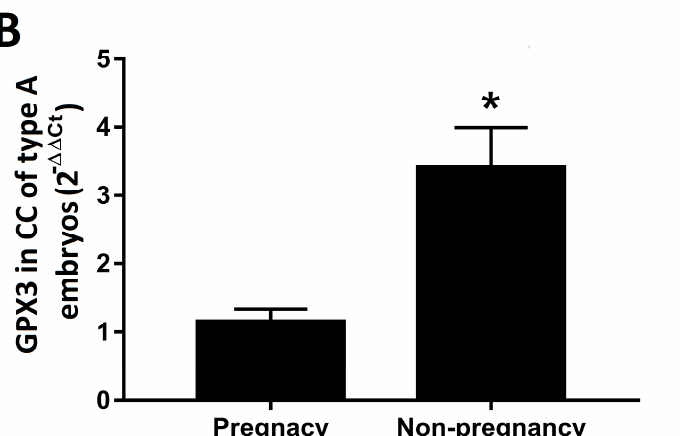
Figure 2. ( A ) Embryo grading. Data represent the % of each grade of embryo quality achieved in both groups for this study. ( B ) Relative expression of the GPX3 mRNA in cumulus cells retrieved from follicles whose embryo achieved grade A quality. Data represent the mean of the calculated values compared to cumulus cells retrieved from follicles of the pregnant group ( n = 17), with the 2 −ΔΔ Ct method, and the standard error of the mean of each group (n = 55). * p = 0.0115 compared to the non-pregnant group.